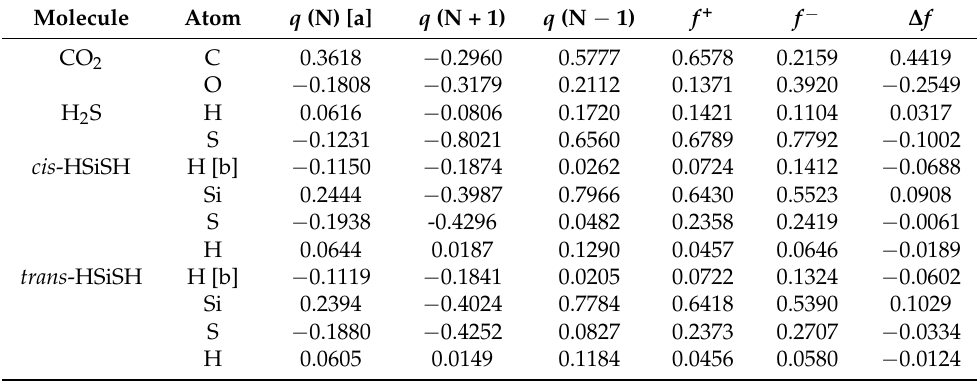
Table 1. Hirshfeld charges, condensed Fukui functions ( f + / f − ), and condensed dual descriptors ( ∆ f ) for the CO 2 , H 2 S, and cis -/ trans -HSiSH molecules.